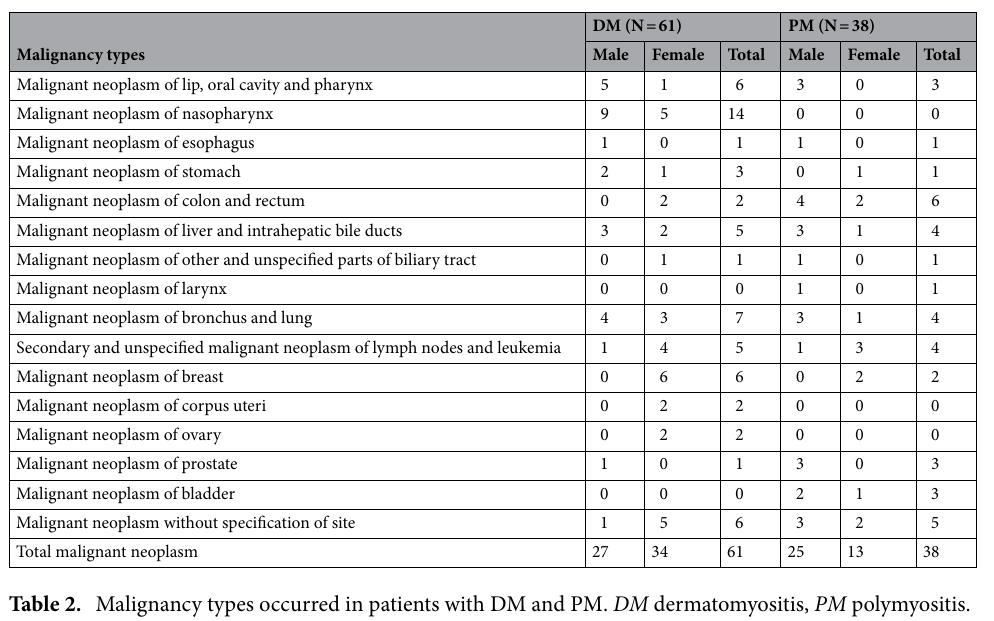
adenocarcinoma. Four of six patients were diagnosed with breast cancer within 1 year after the initial diagnosis of DM. One patient with DM had two malignancies (hepatoma and prostate cancer). Among patients with PM, malignancy of the colon and rectum (15.78%) was the most common malignancy type, and four of six patients had a pathological diagnosis of adenocarcinoma. Only two patients had a diagnosis of colorectal cancer within 1 year after the initial diagnosis of PM, but four patients had a mean interval of approximately 9 years (range 58–148 months) between the initial diagnosis of PM and the occurrence of cancer. Two patients with PM had two malignancies. One patient had colorectal cancer and cervical cancer. The other patient had bladder cancer and cancer of unknown origin. Risk factors for malignancy in patients with DM and PM. To study the risk factors for malignancy in patients with DM and PM, we explored age, sex, diabetes mellitus, hypertension, idiopathic interstitial lung disease, plasma CPK levels, serum tumor markers and autoimmune markers in myositis patients with and with- out malignancy (Table 3). In patients with DM, old age (age ≥ 45 years old) and low serum levels of CPK showed a significant difference between the malignancy group and the nonmalignancy group (p = 0.003 and p = 0.05, respectively). However, sex, diabetes mellitus, hypertension and idiopathic interstitial lung disease did not show significant differences. DM patients with malignancy showed a significantly higher proportion of abnormal AFP and ANA results than patients without malignancy (p = 0.02 and p = 0.01, respectively) based on chi-squared tests. In patients with PM, male and low serum levels of CPK were significantly different between the patients with malignancy group and without malignancy group (p = 0.001, p = 0.003, respectively). PM patients with malignancy showed a significantly higher proportion of abnormal CEA and AFP results than patients without malignancy (p = 0.03 and p = 0.00, respectively). In the univariate Cox regression model, old age (age ≥ 45 years old) was significantly associated with malig- nancy in patients with DM (hazard ratio = 2.72, p = 0.001). In patients with PM, male showed a significantly higher association with malignancy (hazard ratio = 2.86, p = 0.002). In the multivariate Cox regression model, old age (age ≥ 45 years old), male and low serum levels of CPK were significantly associated with malignancies in patients with DM (hazard ratios = 2.05, 2.24 and 2.48, respectively; all p < 0.05). In patients with PM, male and low serum levels of CPK showed significantly higher associations with malignancies (hazard ratios = 5.79 and 3.62, respectively; all p < 0.05) (Table 4). Incidences of malignancy compared with those in previous studies. Table 5 shows a comparison of the crude malignancy incidences from the 2003 TNCR, 2016 TNCR, a previous study from the National Health Insurance Research Database (NHIRD) by Chen et al. 10 and our work. Both our study and Chen’s study showed increased crude malignancy incidences compared with those in the general population. In TNCR data from 2003 to 2016, the three types of malignancy with the highest annual incidences changed from 2003 (breast, hepatic and colorectal) to 2016 (breast, colorectal and lung). During this period, increased incidences of breast, colon and rectal, prostate, esophageal, bladder, hematological and lung malignancies were found. Our results did not show a trend of increasing incidence in the above malignancies. Rather, NPC was the most frequent malignancy in our study and Chen’s study. We segregated our data into the 2001–2007 period so that the study period matched that of Chen’s study. The top three malignancies in patients with DM and PM from 2001 to 2007 were similar to those from 2001 to 2019 (Table 5). Our study showed an increased incidence of malignancy in